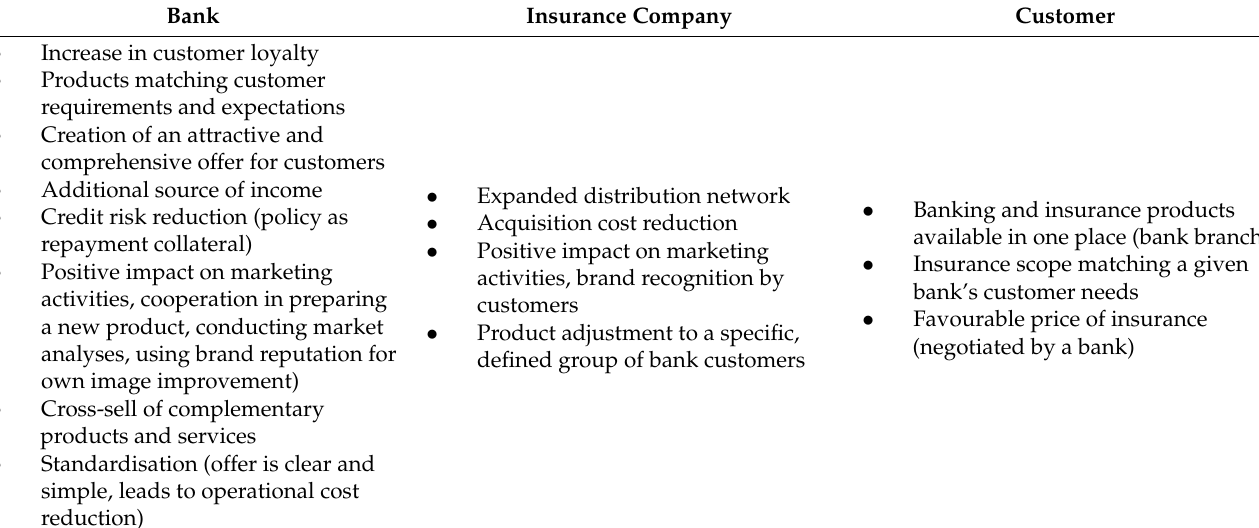
Table 3. Benefits for bancassurance